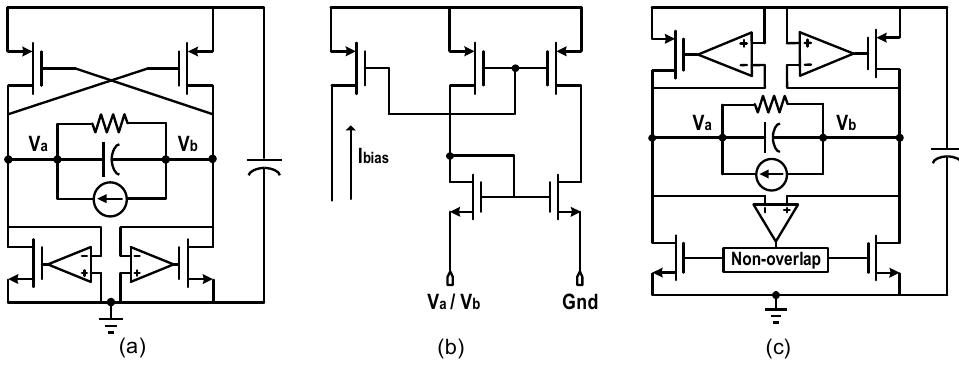
Figure 8. Structure diagrams of ( a ) comparator-controlled active rectifier ( b ) op-amp for active rectifier ( c ) fully comparator-controlled rectifier.